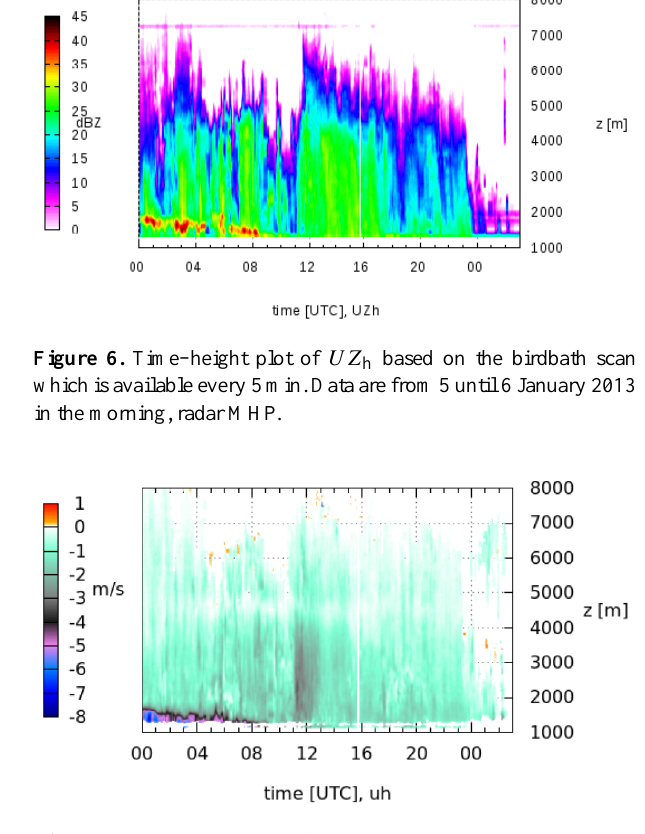
Figure 7. Time–height plot of Doppler velocity based on the bird- bath scan which is available every 5min. Data are from 5 until 6 Jan- uary 2013 in the morning, radar MHP. The data represents the ef- fective terminal fall velocity of the hydrometeors (negative towards the